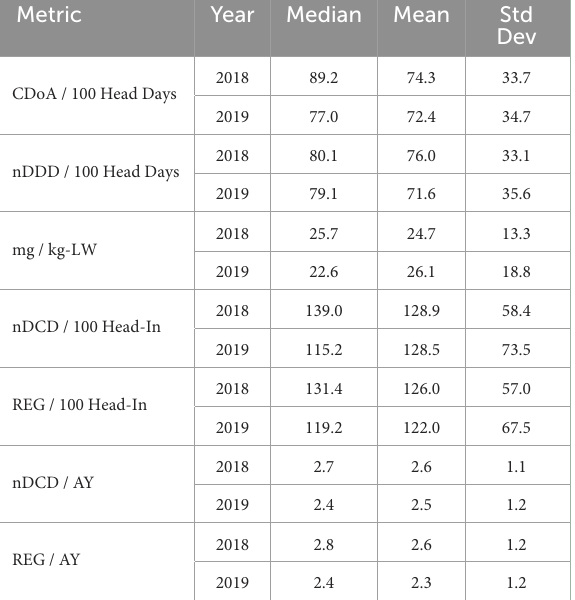
TABLE 4 Median and mean values at the feedyard level for 7 metrics used in ranking